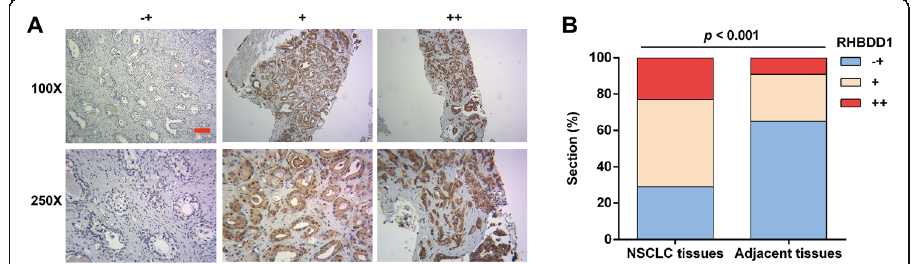
Fig. 2 RHBDD1 is highly expressed in NSCLC tissues. a Representative images of different degrees of RHBDD1 immunohistochemistry staining in NSCLC and adjacent tissues ( − +, weak staining, + moderate staining, ++ strong staining). b A significantly higher percentage of NSCLC tissues than adjacent normal tissues showed high RHBDD1